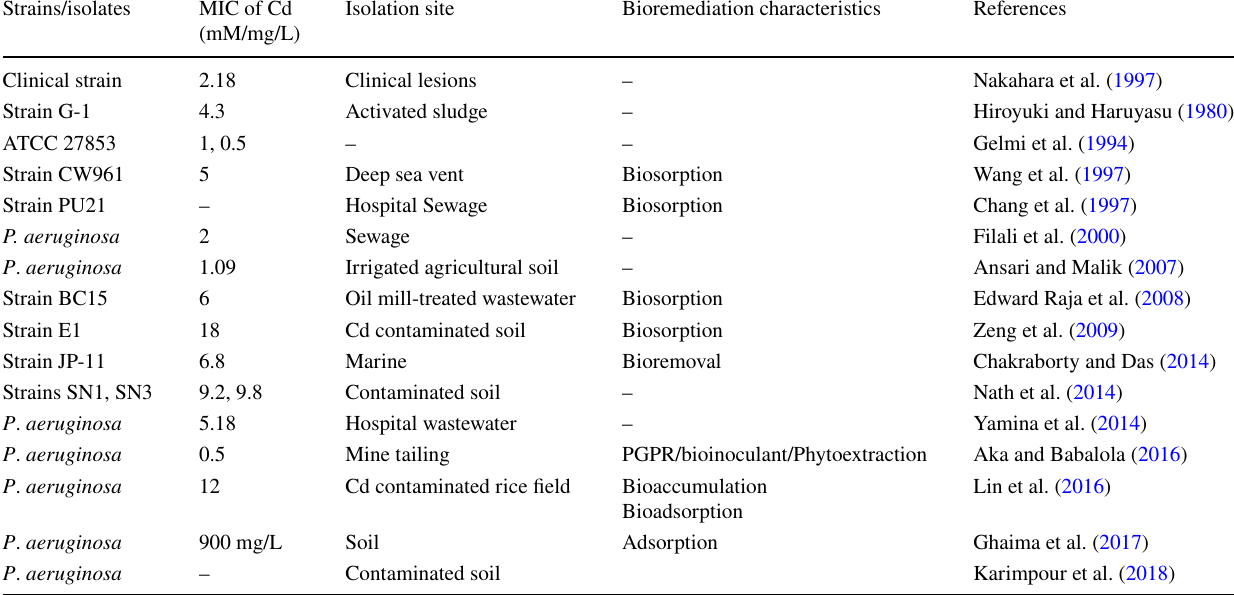
Table 1 Cadmium-resistant P . aeruginosa isolated from different environment regions